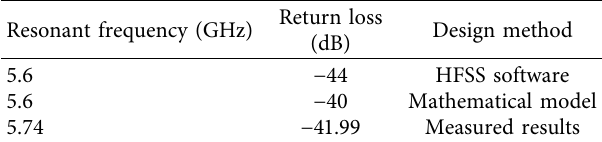
Figure 18: The return loss versus frequency of the proposed an- tenna using mathematical model ( f � 5 . 6GHz ; S 11 � − 40 dB ) . Table 4: Comparison between simulation, mathematical model, and measured